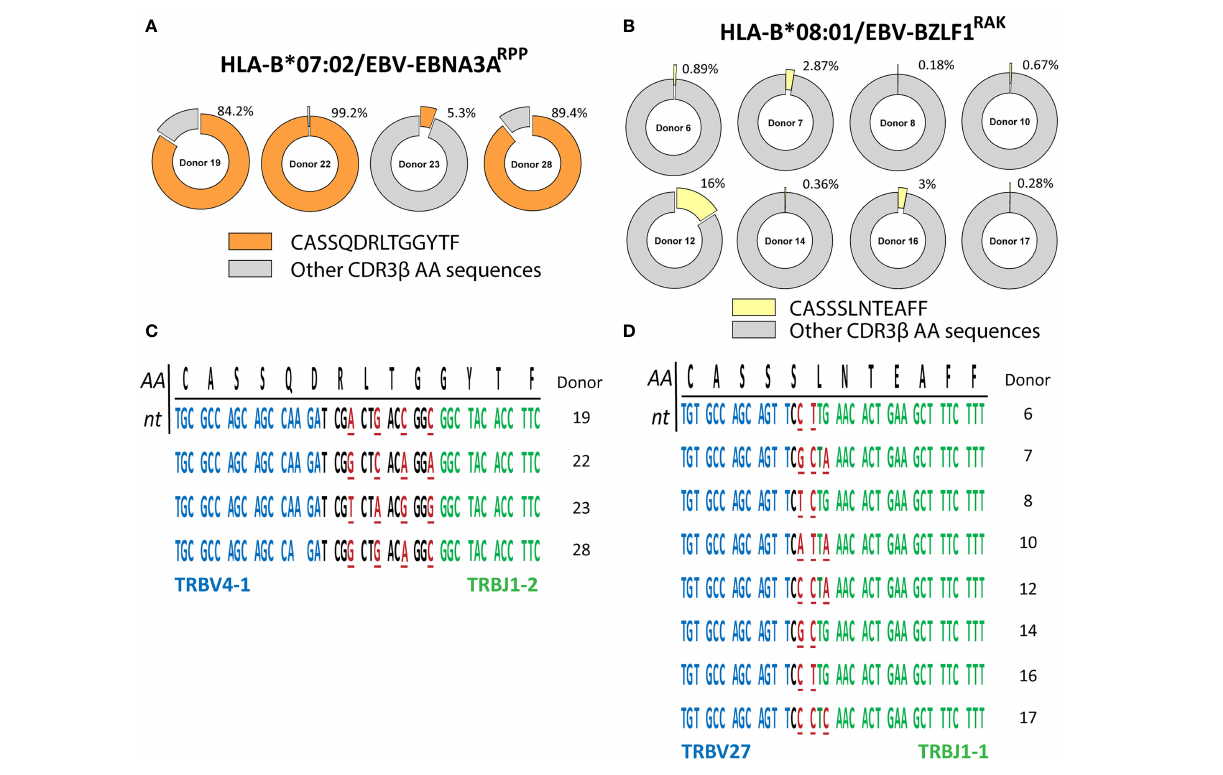
FIGURE 2 | PUB-I CDR3 b -sequences can be found in different individuals with small nucleotide-differences as a result of convergent recombination. The library of virus- speci fi c CDR3 b AA-sequences contained 131 sequences that were found in multiple different individuals ( ≥ 2). The nucleotide-sequences of these CDR3 b AA-sequences were analyzed to investigate differences and similarities. (A, B) Shown are two representative examples of the frequencies of the PUB-I CDR3 b AA-sequences CASQDRLTGGYTF and CASSSLNTEAFF, that were speci fi c for HLA-B*07:02-restricted EBV-EBNA3A RPP and HLA-B*08:01-restricted EBV-BZLF1 RAK , respectively. (C, D) Shown are the nucleotide-sequences of the CDR3 b AA-sequences CASSQDRLTGGYTF and CASSSLNTEAFF that were shared by different individuals. Underlined nucleotides represent differences between the different individuals. Nucleotides in red represent differences to the consensus sequence. Nucleotide-sequences in blue and green represent perfect alignment with the germline sequences of the TRBV-gene and TRBJ-gene, respectively. AA, amino-acids; nt,